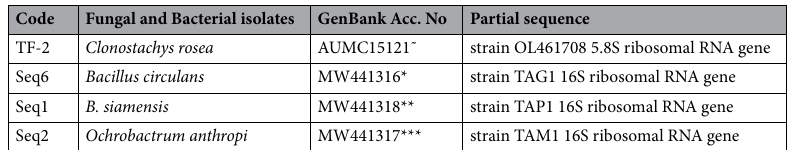
Table 6. Code and GenBank accession number for fungal and bacterial bioagent isolates recovered from healthy lucky bamboo plants. ˜https:// www. ncbi. nlm. nih. gov/ nucco re/ OL461 708, *https:// www. ncbi. nlm. nih. gov/ nucco re/ MW441 316, **https:// www. ncbi. nlm. nih. gov/ nucco re/ MW441 318, ***https:// www. ncbi. nlm. nih. gov/ nucco re/ MW441